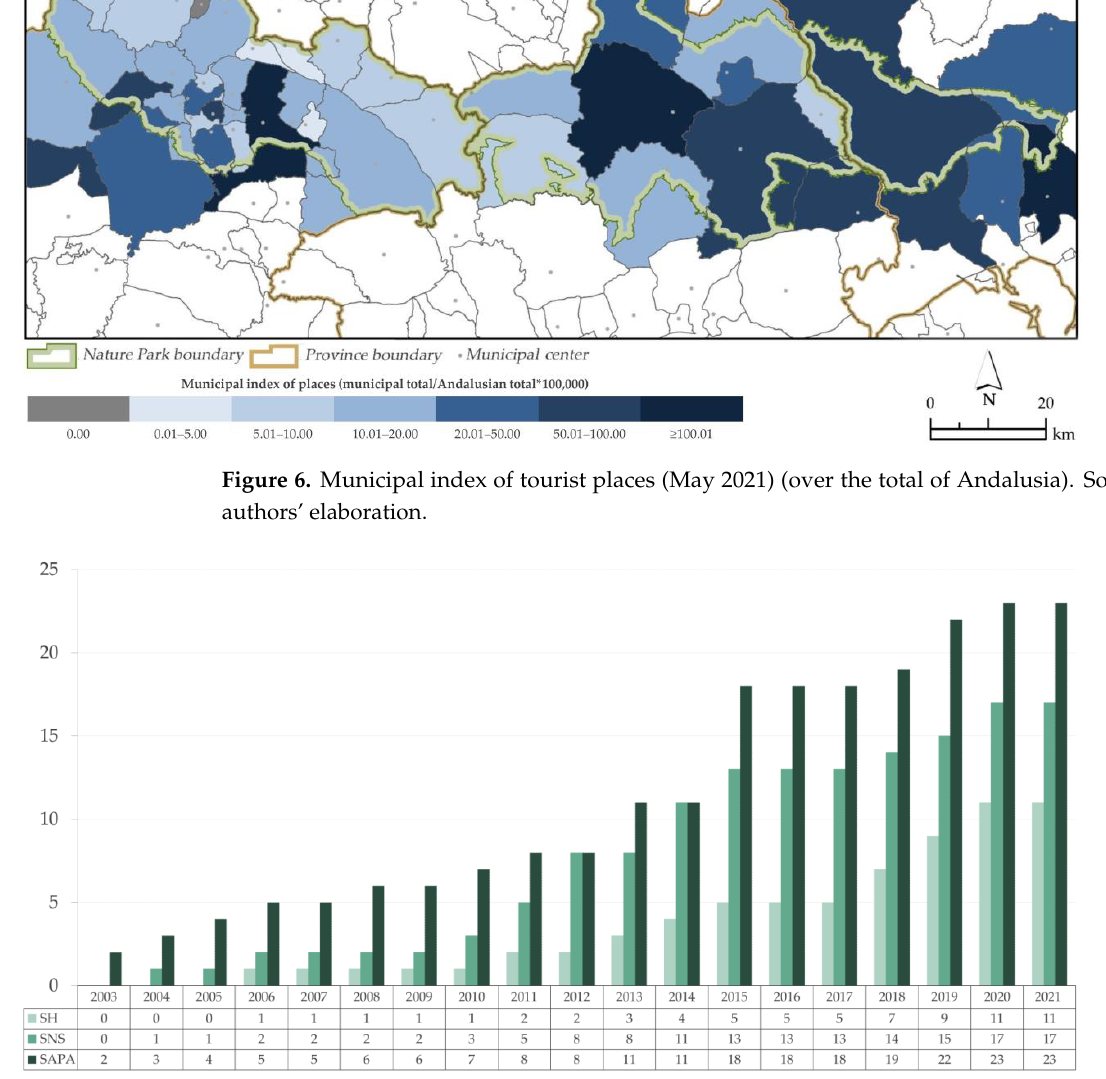
Figure 7. Evolution of receptive companies and activities. Source: [79]; authors ’ elaboration.